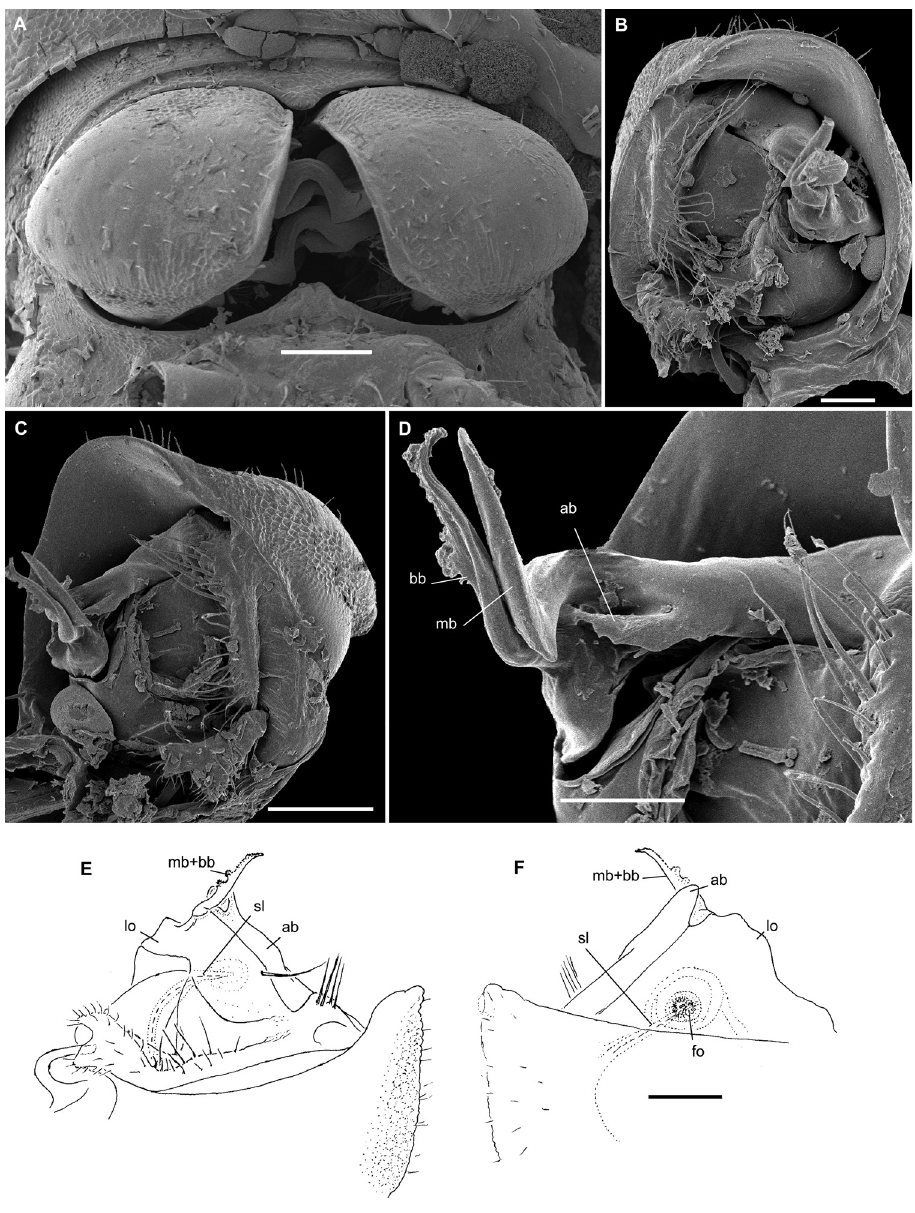
Figure 16. Hemisphaeroparia fusca sp. n., ♂ paratype A SEM micrographs of both gonopods in situ, ventral view B–D SEM micrographs of left gonopod, submesal, ventromesal and enlarged ventromesal views, respectively E, F left gonopod of holotype (branch bb fully concealed), mesal and lateral views, respectively. Scale bars: 0.1 mm ( A, C, E, F ), 0.05 mm ( B, D ). Abbreviations: ab apical branch of telopo- dite, fo foramen, lo lobe, mb+bb medial and basal branches, sl